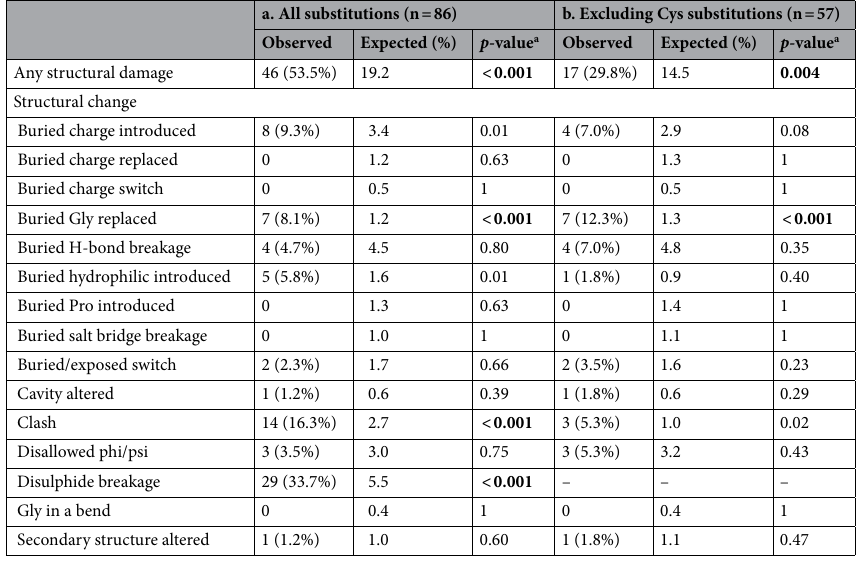
Table 3. Predicted structural changes caused by collagen IV α5 NC1 missense variants reported in LOVD. Significant values are in bold. a For comparisons of each individual structural change the significance threshold was set at p < 0.0033, accounting for 15 tests.